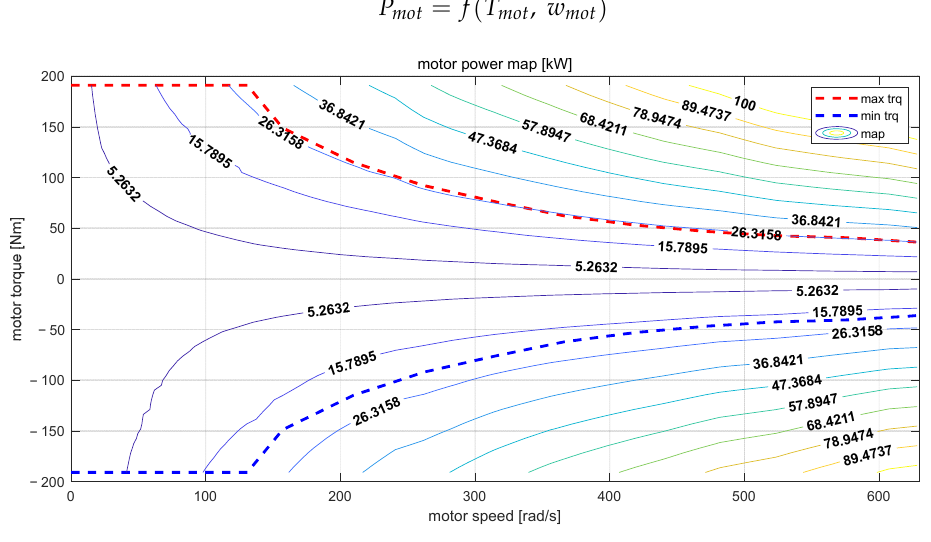
Figure 3. Electric motor power map.